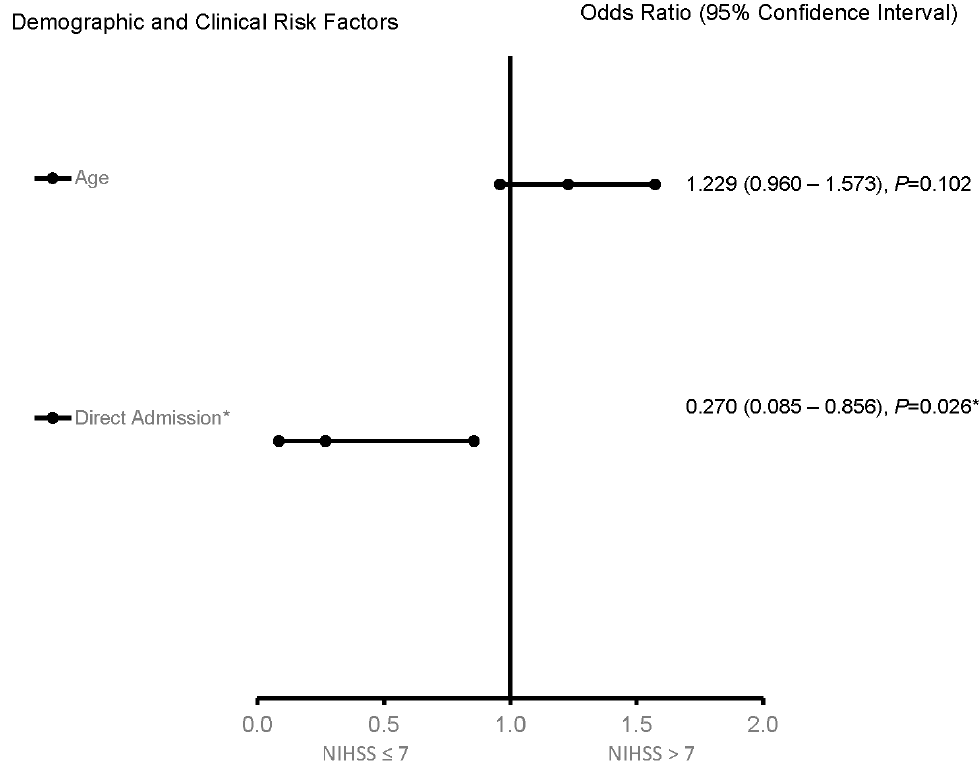
Figure 5. Factors associated with stroke severity for patients ≥ 75 years old in the telestroke database. Adjusted OR > 1 denotes factors associated with having an NIHSS score > 7 or worsening neurologic outcomes. Hosmer–Lemeshow test: p = 0.676; Cox and Snell: R2 = 0.098. The overall classi fi ed per- centage of 76.3% was applied to check the fi tness of the logistic regression model. * indicates statis- tical signi fi cance ( p <0.05) with a 95% con fi dence interval.